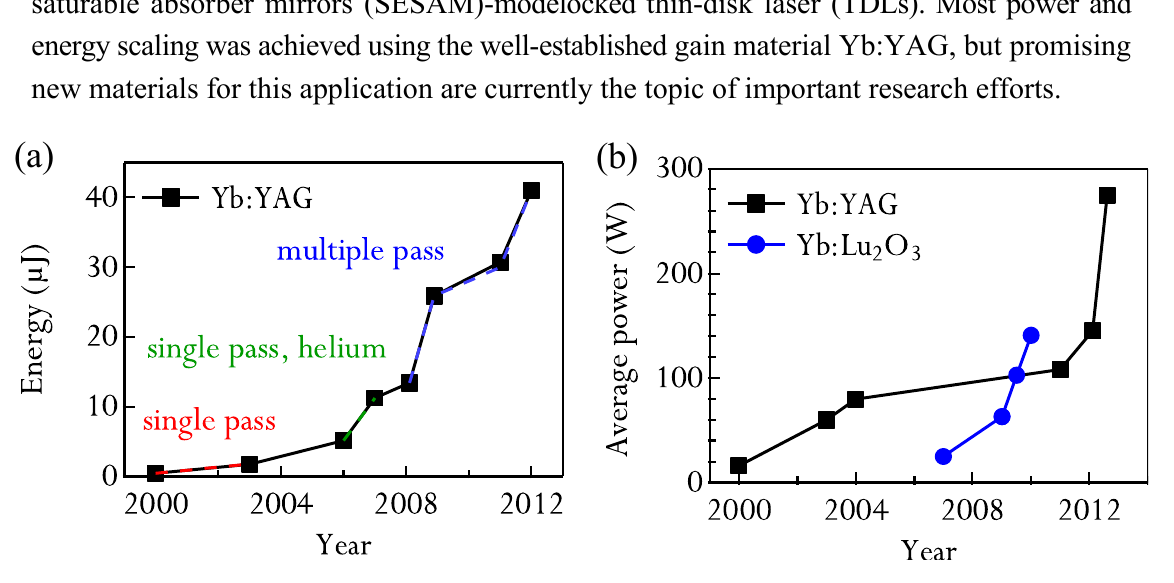
Figure 1. Evolution of pulse energy ( a ) and average power ( b ) of ultrafast semiconductor saturable absorber mirrors (SESAM)-modelocked thin-disk laser (TDLs). Most power